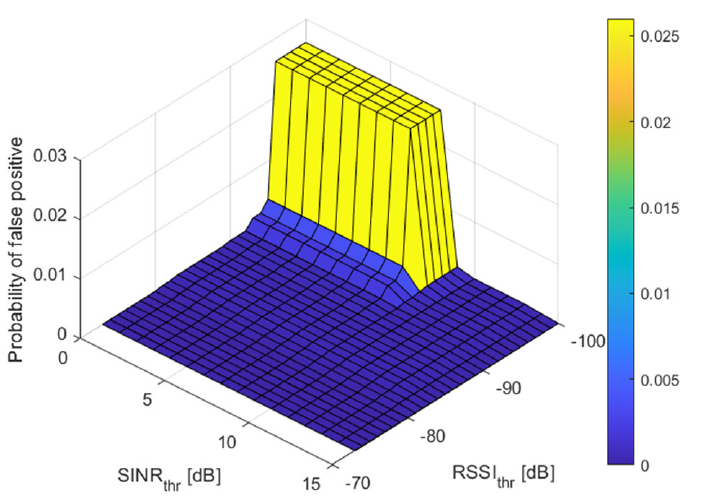
Figure 15. The probability of false positive decision for different threshold values for RSSI and SINR while the threshold for RSRP was set to − 133 dBm and the threshold for RSRQ was set to − 17